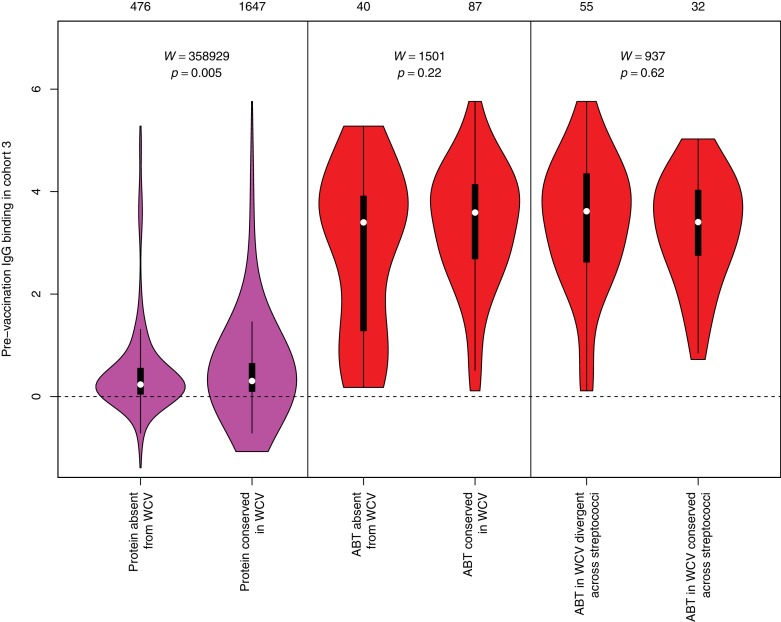
Pre-vaccination IgG binding in cohort three to protein categories defined in Figure 4.The left violin plot shows the distribution of pre-WCV IgG binding in cohort three for non-DCL array probes, split by whether they represent proteins with close orthologues in the WCV strain RM200 (defined as ≥90% amino acid identity) or not. The responses to the proteins in the vaccine are slightly higher prior to administration, which may reflect the rarity of those proteins absent from RM200; such low frequency proteins are less likely to have triggered a recent immune response. The central panel shows the same comparison of pre-vaccination immune responses, but further constraining the dataset to probes representing the proteins classified as ABTs based on high pre-vaccination IgG binding. The right panel stratifies the 87 probes corresponding to ABTs with close orthologues in RM200 by whether protein on the array is also conserved with ≥90% sequence identity in S. mitis and S. pseudopneumoniae. The number of probes in each category is shown at the top of the plot. The results of Wilcoxon rank sum tests (W) and the associated statistical significance (p) are annotated on each panel.